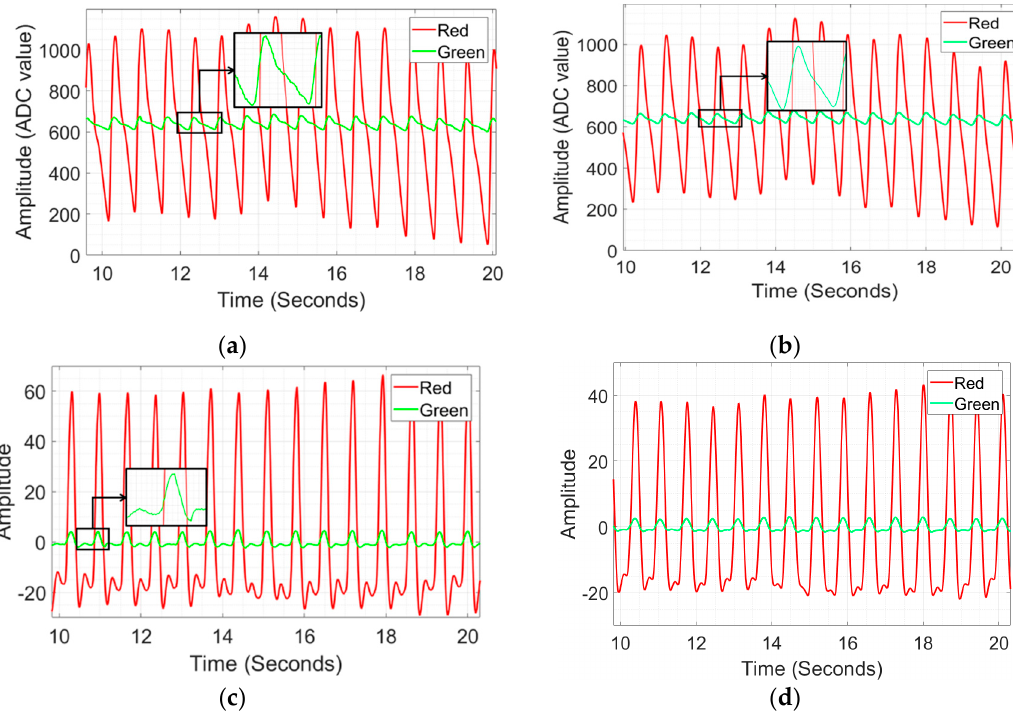
Figure 22. Output of red and green PPG signals and the peak detection of the PPG signals: ( a ) output of the proposed electronic circuit, ( b ) the moving average output (with a window size of 15), ( c ) differentiation of the moving average output, and ( d ) the moving average of the differentiation (with a window size of 20).